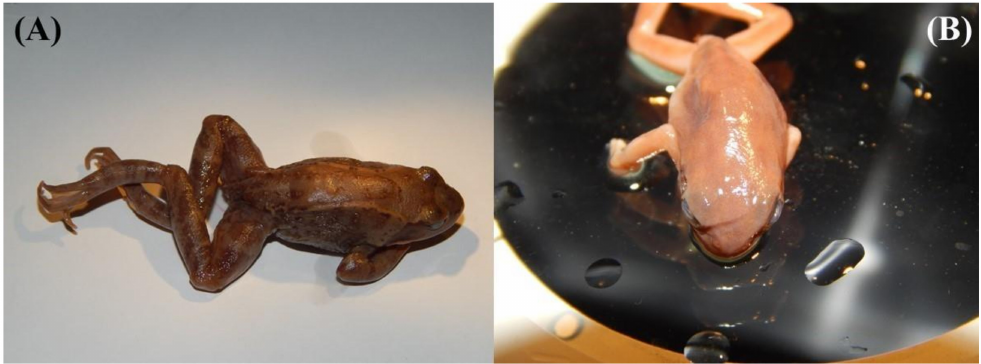
Figure 5. Pictures of Rana coreana or Rana amurensis ( A ) and Dryophytes suweonensis ( B ) used for species identification in the vicinity of Pyongyang. The samples are stored at the ZISP (Zoological Institute of the Russian Academy of Sciences, St. Petersburg,